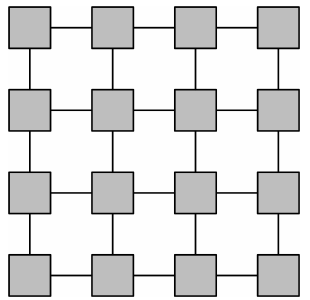
Figure 1: Graph G = ( V , E ) of a 4 by 4 image with a 4 connec-